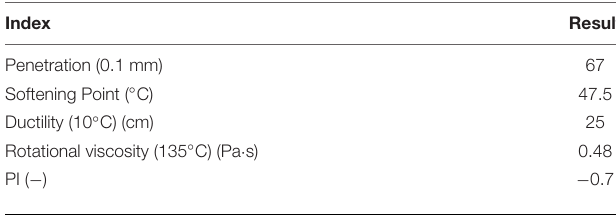
TABLE 1 | Properties of asphalt.